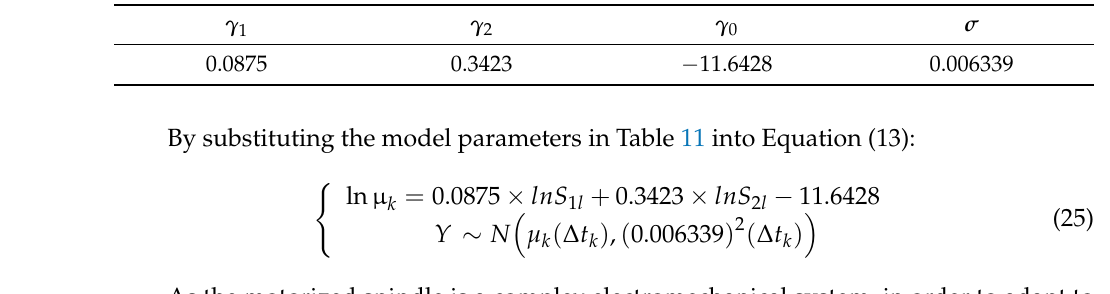
Table 11. Parameters of accelerated degradation model of the motorized spindle under double stress.